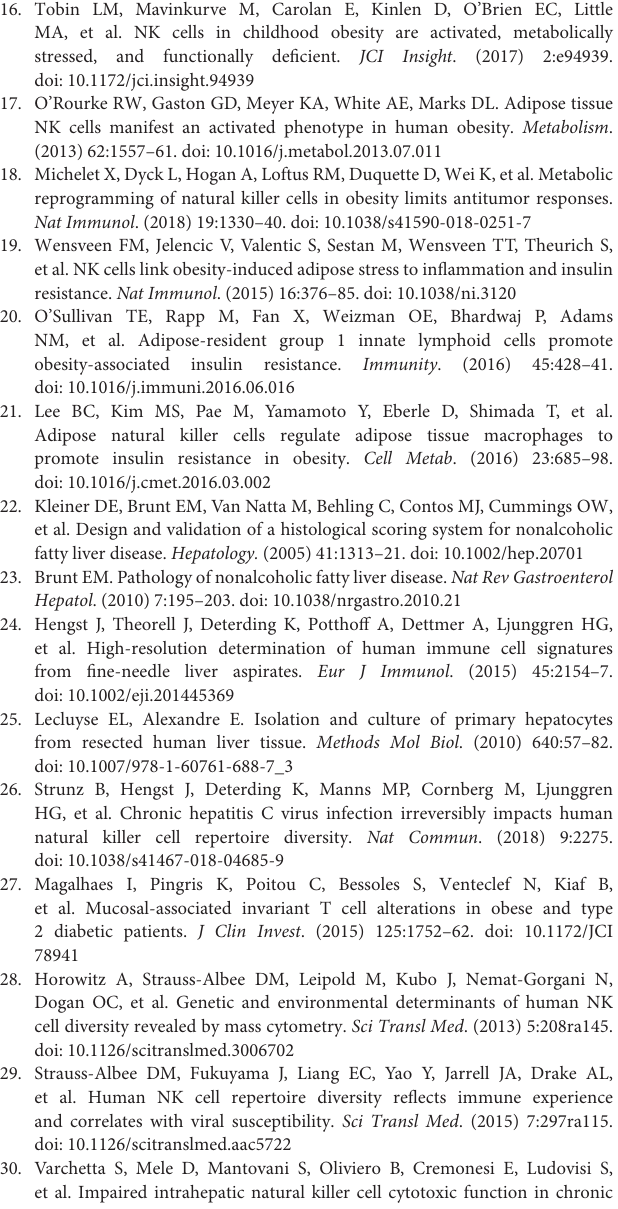
Supplementary Figure 1 | Expression of NKG2D ligands on primary human hepatocytes. Representative histogram of flow cytometry stainings of NKG2D-ligands as well as HLA-ABC and CD155, ligand of DNAM-1, on primary hepatocytes. One representative staining out of